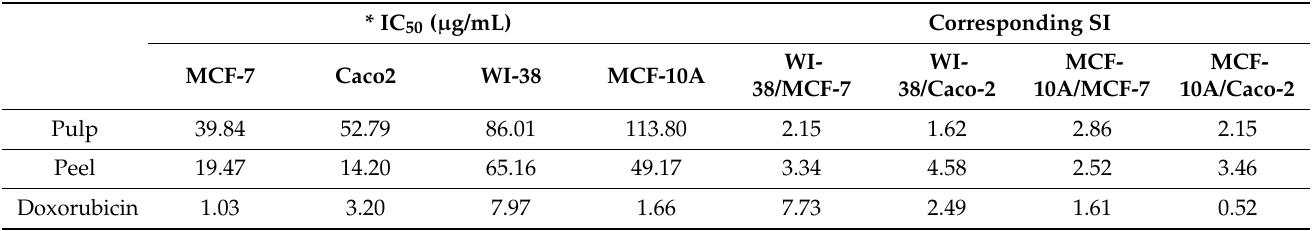
Table 4. IC 50 values and selectivity index (SI) of peel and pulp H. undatus extracts against MCF-7, Caco-2, WI-38, and MCF-10A cell